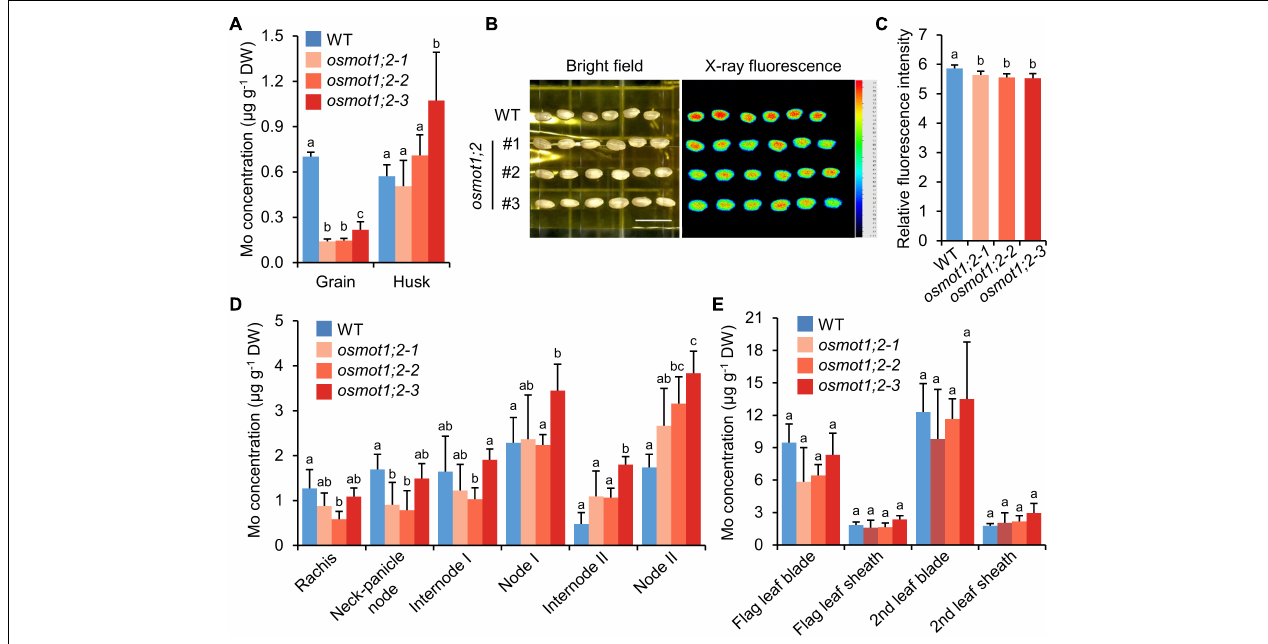
FIGURE 5 | Knockout of OsMOT1;2 alters Mo allocation among various tissues at harvesting stage. (A) The Mo concentration in grains and husks of WT and osmot1;2 . (B) The images of µ -XRF of grains of WT and osmot1;2 . Left: the image at bright filed; right: the image scanned by µ -XRF. (C) Relative fluorescence intensity of µ -XRF images shown in (B) . (D,E) The Mo concentrations in different tissues of WT and osmot1;2 at mature stage. Data in (A,C–E) are presented as means ± SD with five or six biological replicates. Columns with different letters in (A,C–E) indicate significant differences at P < 0.05 (Tukey’s honestly significant difference